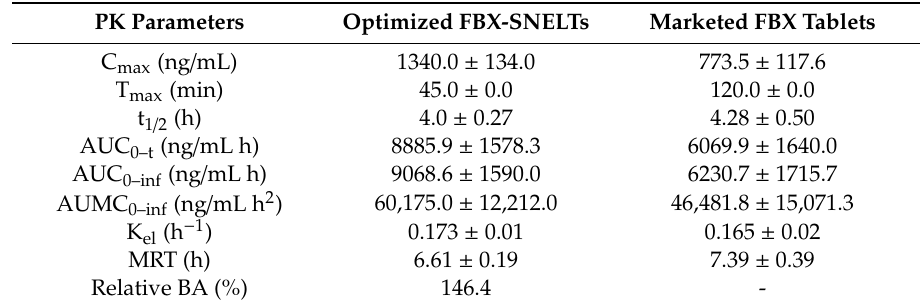
Table 5. Pharmacokinetic parameters of the optimized FBX-SNELTs compared to the marketed FBX tablets (mean ± SD; n =